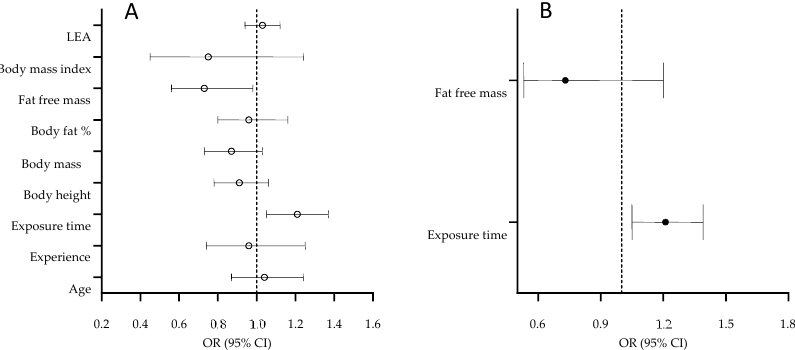
Figure 2. Univariate ( A ) and multivariate ( B ) correlates of bone injury in contemporary dance. The volume of training/competition per week (exposure time) was higher in dancers who reported bone injury (OR = 1.21, 95%CI: 1.05–1.37). Meanwhile, FFM was inversely related bone injury (OR = 0.73, 95%CI: 0.56–0.98) (Figure 2A). The multivariate model ev- idenced that exposure time was the only significant predictor of bony injury, with a higher (OR = 1.21, 95% CI: 1.05–1.39; HL = 6.77, p = 0.56) (Figure